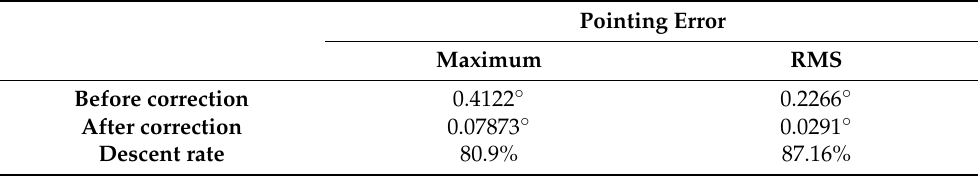
Table 4. Simulation results of inverse solution error correction.